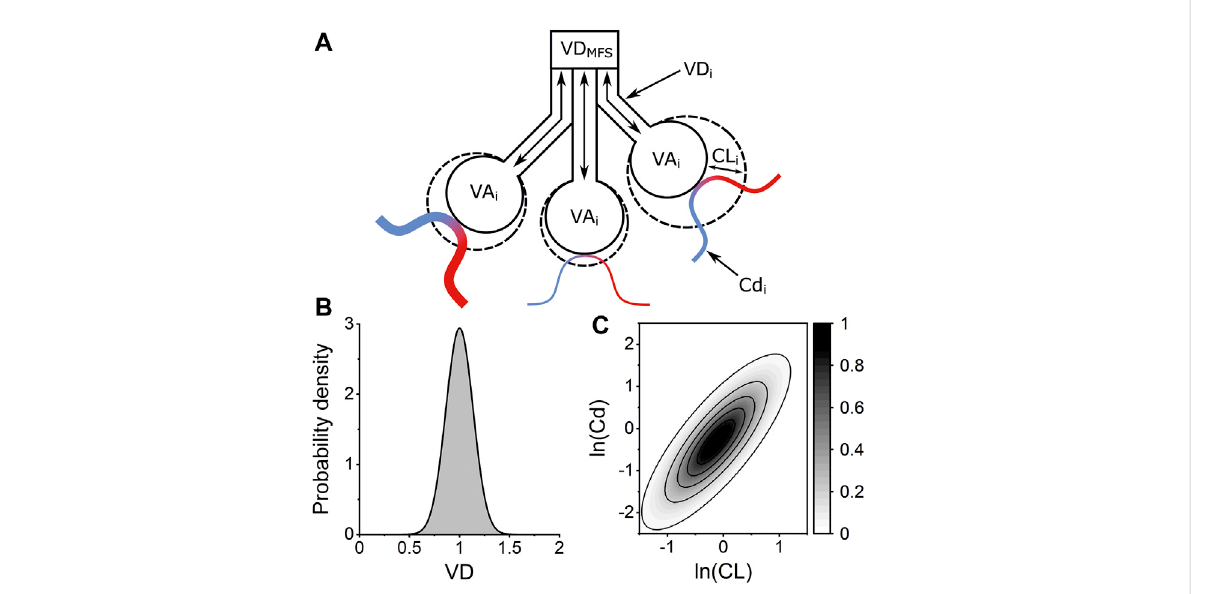
FIGURE 1 Lognormal Lung Model of pulmonary inhomogeneity. (A) Schematic of three lung units within the Lognormal Lung model. Each unit has the same alveolar volume at FRC (VA i ) but the units vary in their fractional share of total anatomical deadspace volume (VD i ), lung compliance (CL i ), and vascular conductance (Cd i ). Venous blood (blue) is oxygenated by the alveolar gas and departs as arterial blood (red). The anatomical deadspace introduced into the airway by the molecular fl ow sensor (VD MFS ) is accounted for within the model. (B) Example of normal distribution used to describe the distribution of VD, the standardised deadspace to alveolar volume ratio, across the 125 lung units within the model. The width of this distribution is de fi ned by the standard deviation, σ VD, with an integrated area of 1. (C) Contour plot illustrating the bivariate lognormal distribution which describes thevariation lung compliance (CL) andvascular conductance(Cd)across thelungunits within theLognormal Lungmodel. Contour intervals are values for the probability density